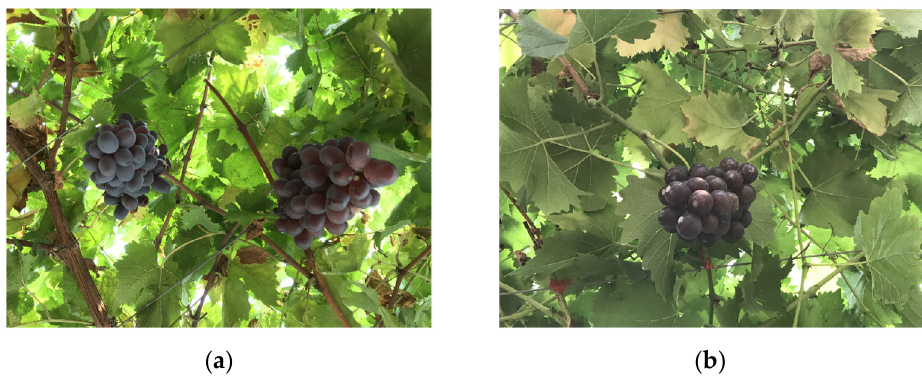
Figure 1. Images of grapes. ( a ) Grape image 1. ( b ) Grape image 2.